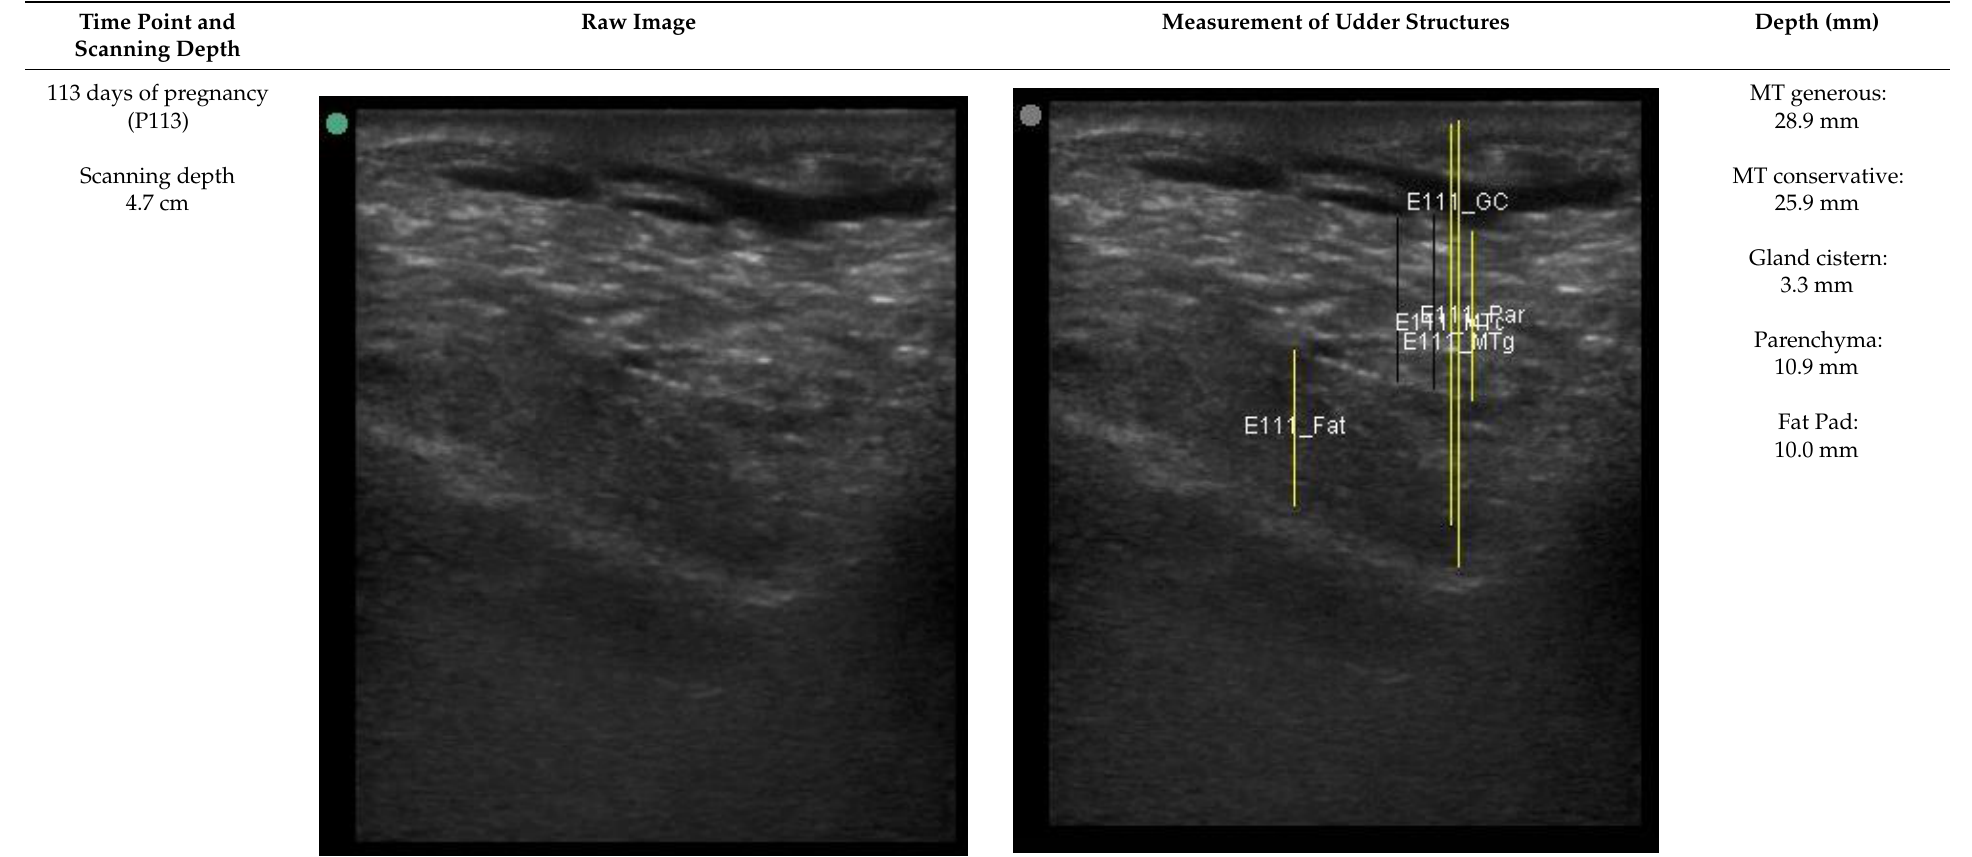
Table A1. Drawing template of mammary ultrasound images in late pregnancy (107 days of pregnancy; P107) in four different yearling ewes.